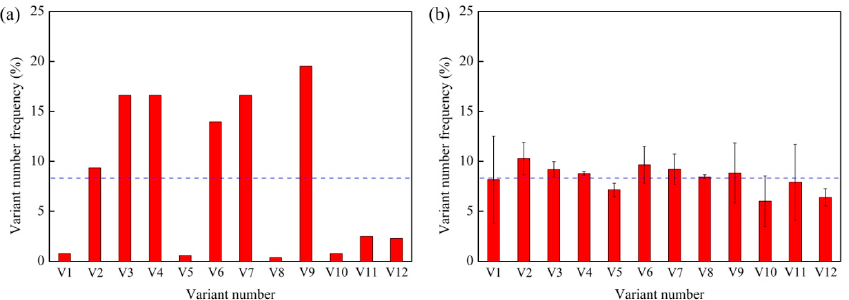
Figure 5. Statistical results of the α 2 ′ variant number frequency for ( a ) The local map shown in Figure 4 and ( b ) three large maps with area of about 250 × 150 μ m 2 for each.